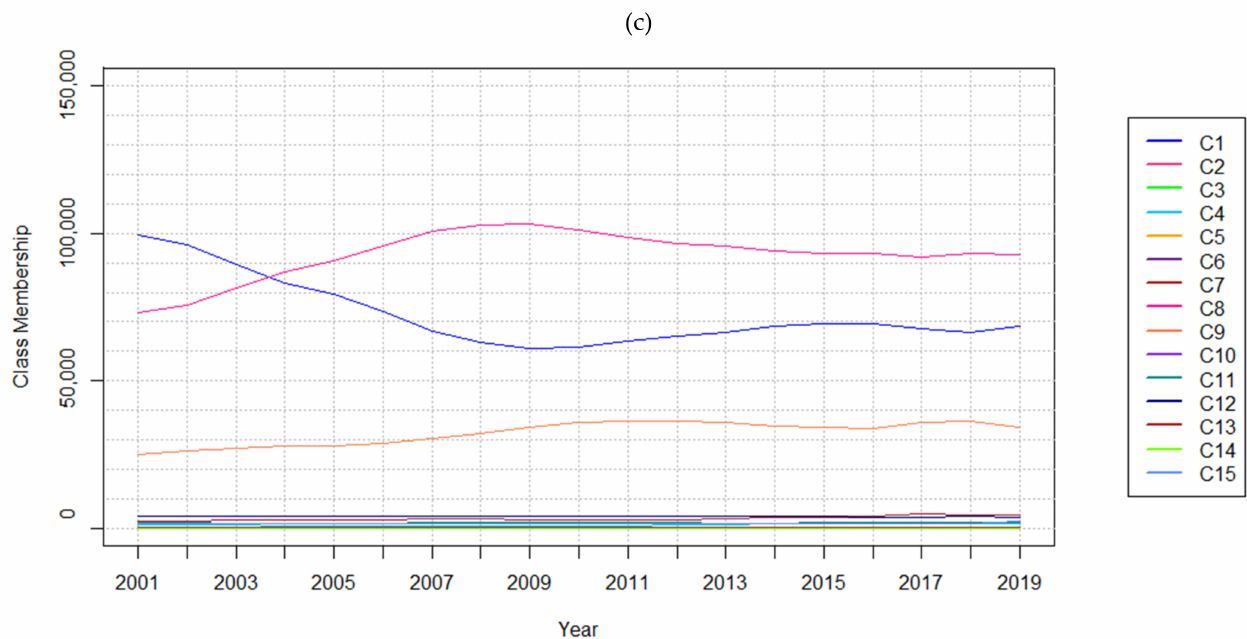
Figure 4. Number of cells belonging to each class at each timestep in the ( a ) 4 class, ( b ) 8 class, and (c ) 16 class real-world LC datasets. Class membership” shows how many cells belong to each class at each timestep. Table 5. Number of cells belonging to each class at various timesteps (considering three-year temporal resolution) in the